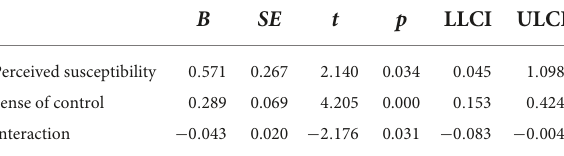
TABLE 5 Moderation effect of sense of control on the relationship between perceived severity and